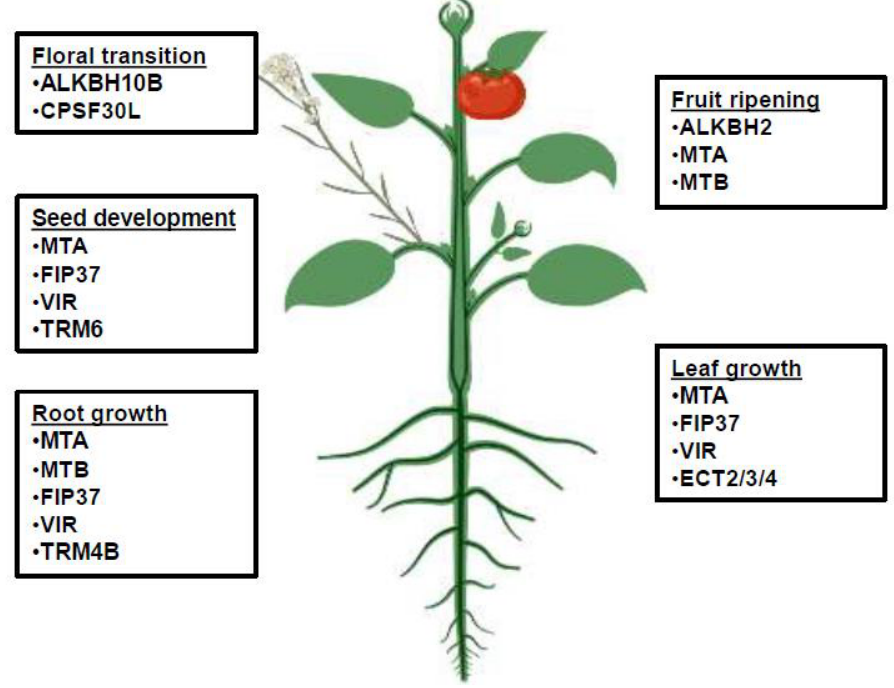
Figure 1. Regulation of plant’s development by post-transcriptional modifications (m 6 A and m 5 C); post-transcriptional modifications regulated by different writer, eraser, and reader proteins affect various plant developmental processes including seed development, leaf and root growth, floral transitions, and fruit ripening.